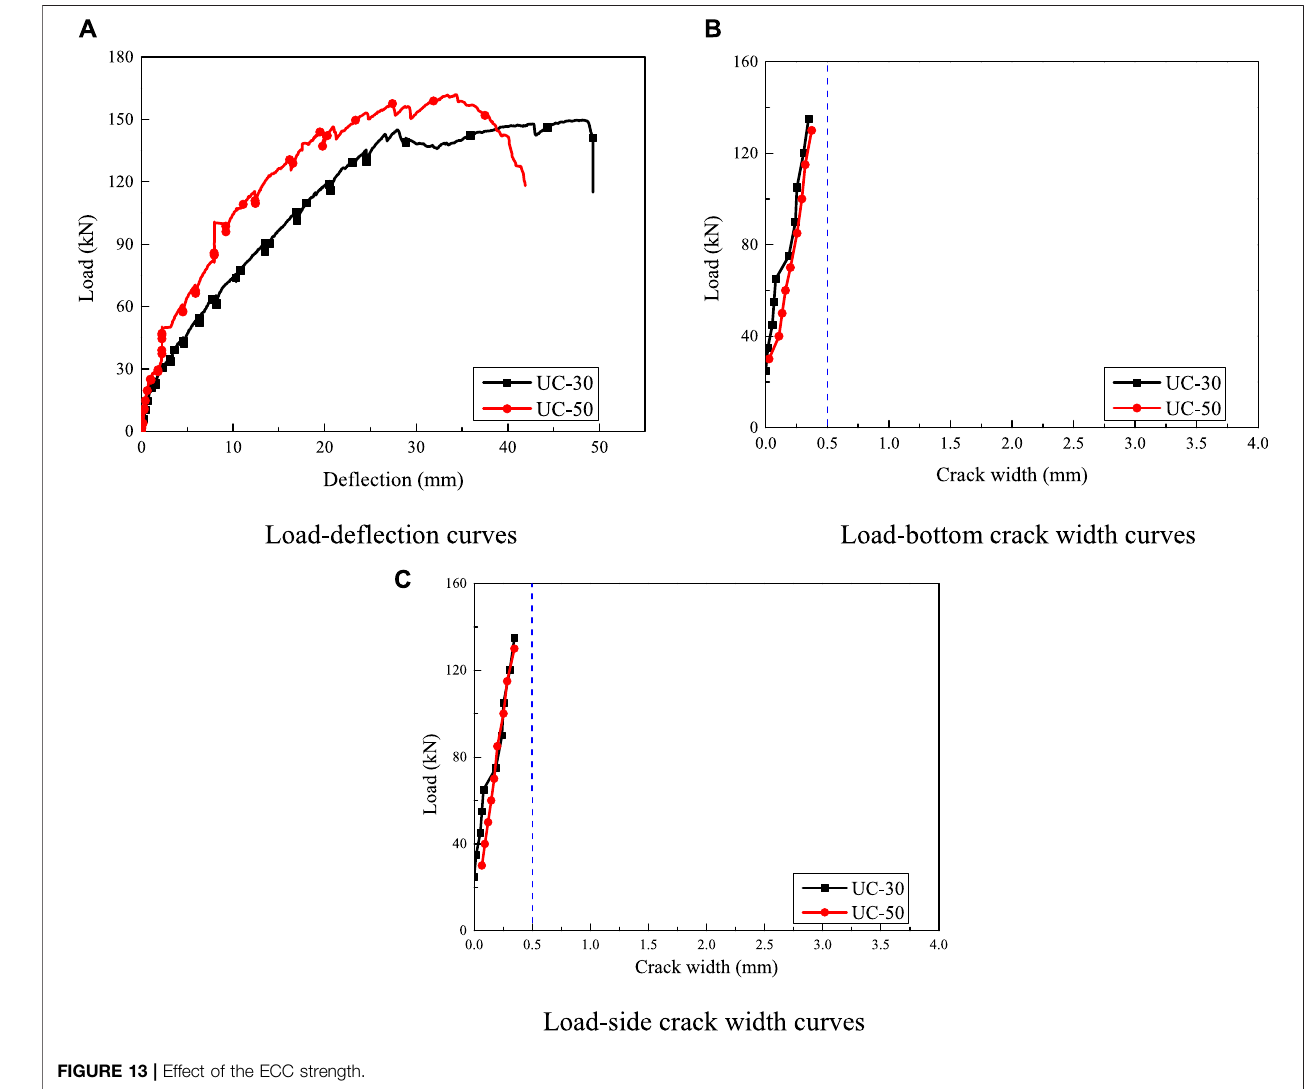
FIGURE 13 | Effect of the ECC